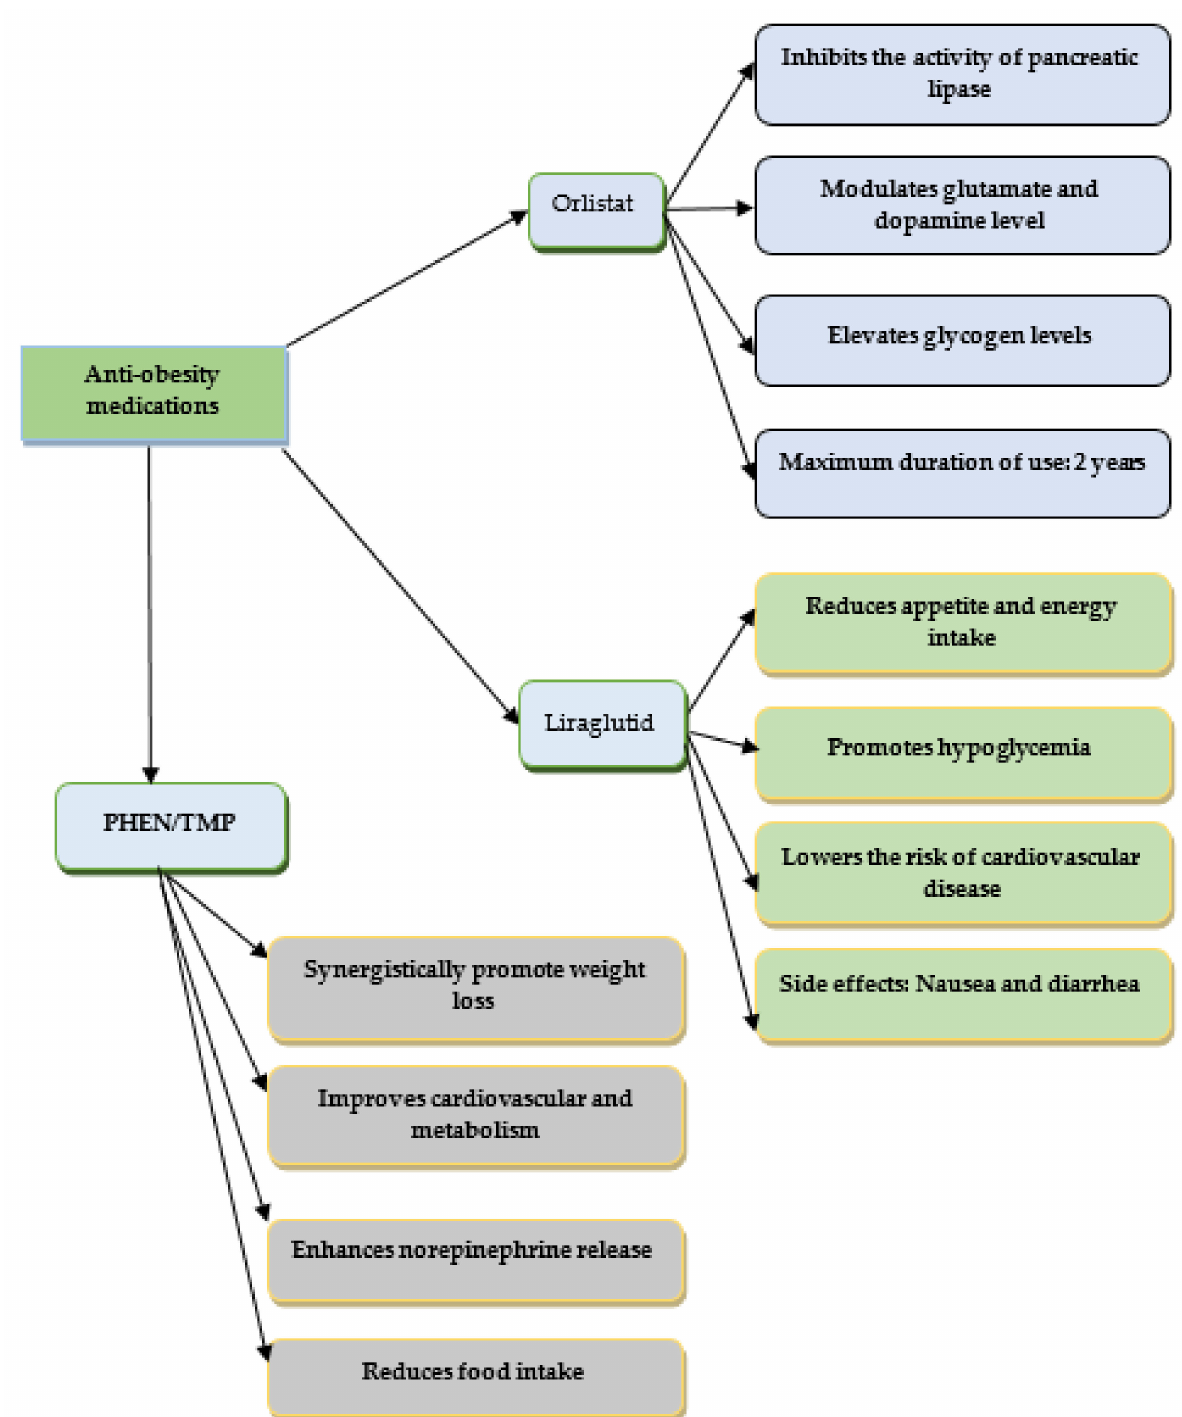
Figure 1. The anti-obesity effects of Orlistat, Liraglutide, and